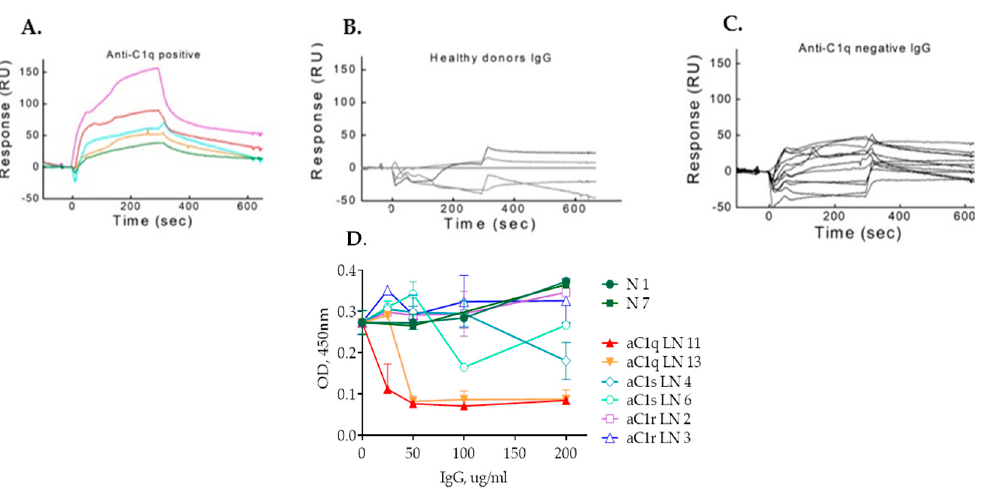
Figure 2. Dynamics of the levels of anti-C1 autoantibodies over time. Dynamics of the levels of anti − C1q ( A ), anti − C1r ( B ) and anti − C1s autoantibodies ( C ) over time. Only the patients for whom two or more samples were available are included in the figure. The dotted line represents the positivity cut-off, determined as average ± 3 SD of the signal, obtained from the plasma of 81 healthy donors.